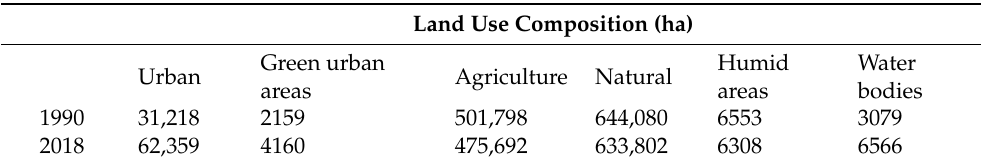
Table 1. Land use composition in the Izmir metropolitan area between 1990 and 2018. Acknowledg- ment or credit of the Copernicus Sentinel data collection acquired through the Sentinel Hub services. Originally downloaded from Copernicus Sentinel data processed by User. Land Use Composition (ha) Green urban Humid Water Urban Agriculture Natural areas areas bodies 1990 31,218 2159 501,798 644,080 6553 3079 2018 62,359 4160 475,692 633,802 6308